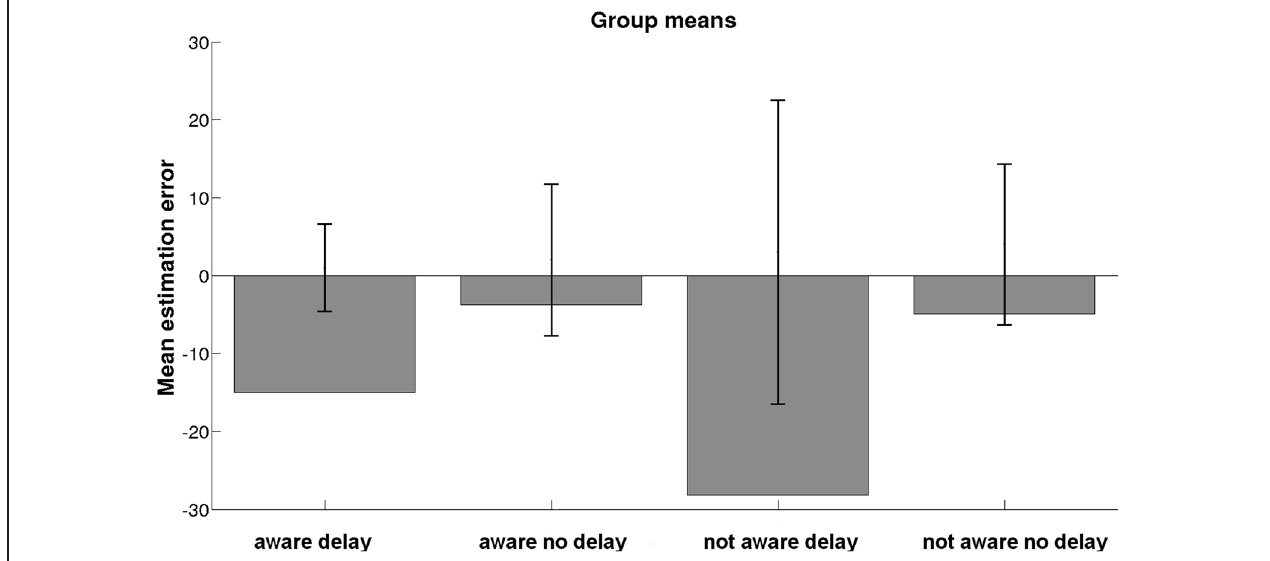
FIGURE 2 | Mean estimation errors for each experimental group; error bars show standard